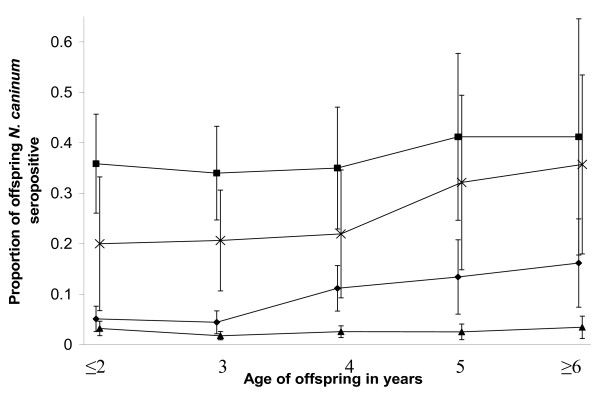
The proportion of offspring N. caninum seropositive by age at testing, dam N. caninum status and herd mean seroprevalence < 10% or ≥ 10%, 95% confidence intervals included (Dataset A – 29,782 samples, 15,736 cattle, 114 herds, all cattle for the whole 4-year study period). Squares represent dam always positive in herd with mean seroprevalence ≥ 10%, crosses represent dam always positive in herd with mean seroprevalence < 10%, dots represent dam always negative in herd with mean seroprevalence ≥ 10% and triangles represent dam always negative in herd with mean seroprevalence < 10%.